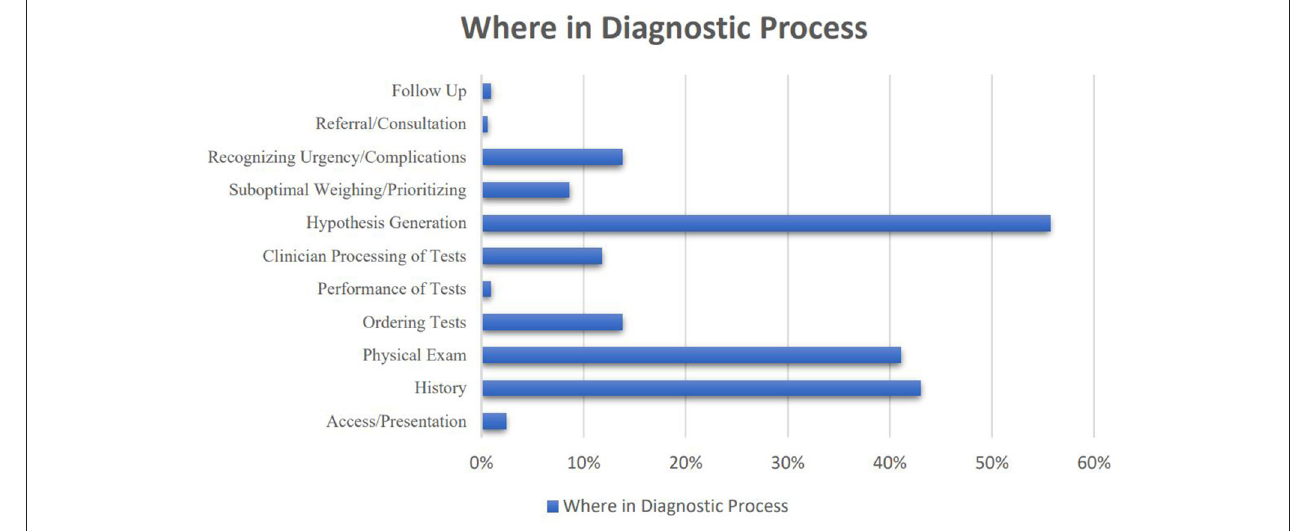
FIGURE 2 | Where errors occurred in the diagnostic